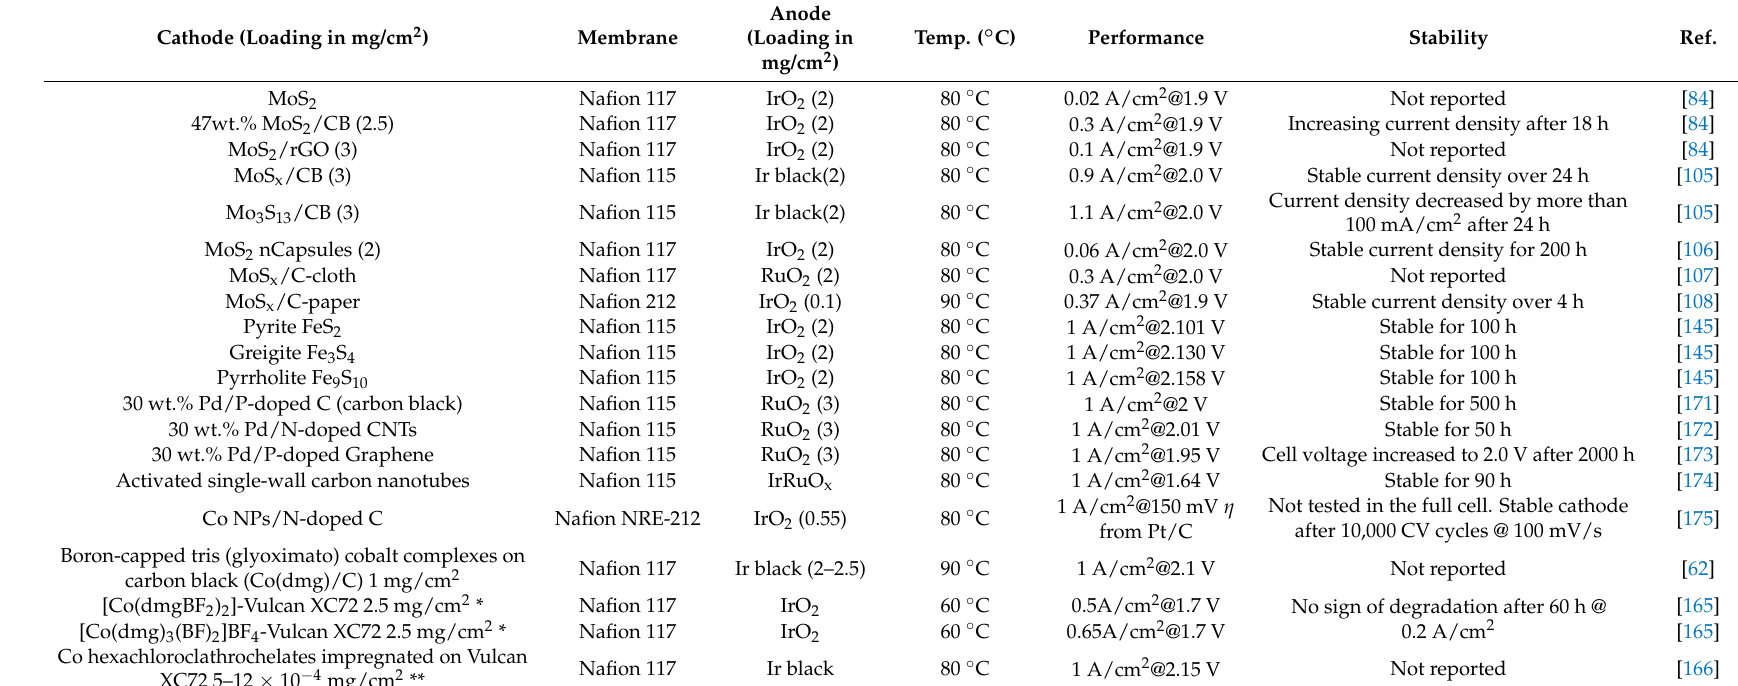
Table 3. Summary of full PEM WE cells with EACs as